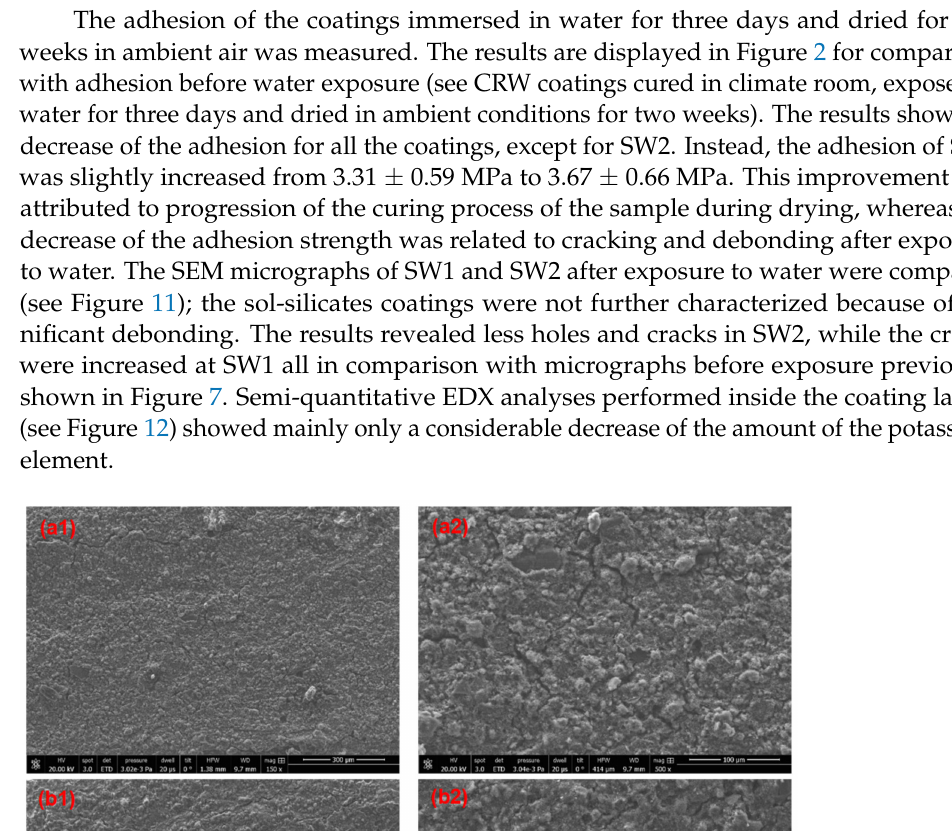
Figure 10. Bow deformation of a test specimen (SW2) after three-day stay in water.